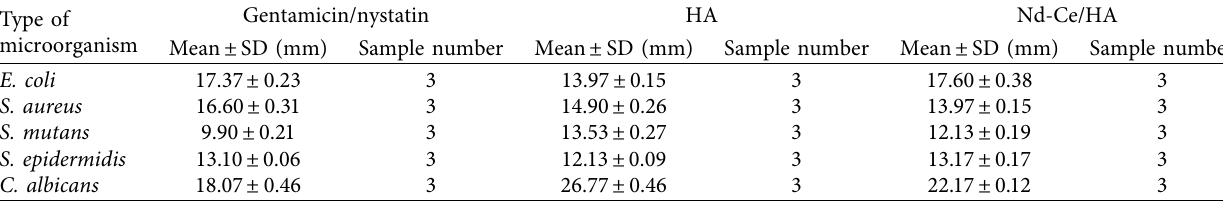
Table 3: Inhibition zone (mean ± standard deviation) of gentamicin/nystatin, HA, and Nd-Ce/HA.